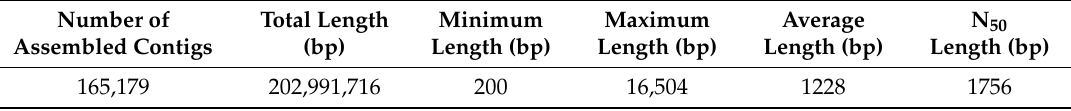
Table 2. Summary of transcript-assembled contigs used as an onion reference reported by Kim et al. [31]. Number